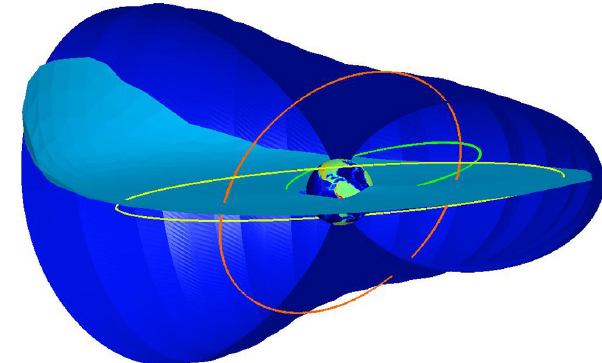
Fig. 2. Mean ratio over the full simulation grid of the PSD deduced at 0.1 or 10s time step to the “reference” PSD performed at 1s time step.